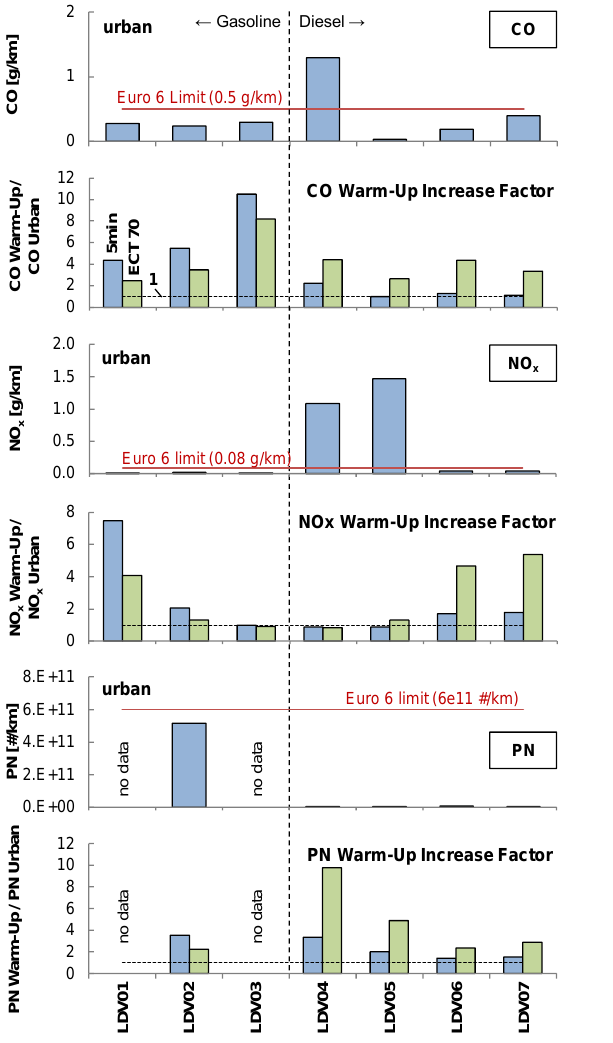
Fig. 10. Cumulated emissions in stop&go By engine stop, there are no emissions produced, but by engine start, there is always an emission peak. The